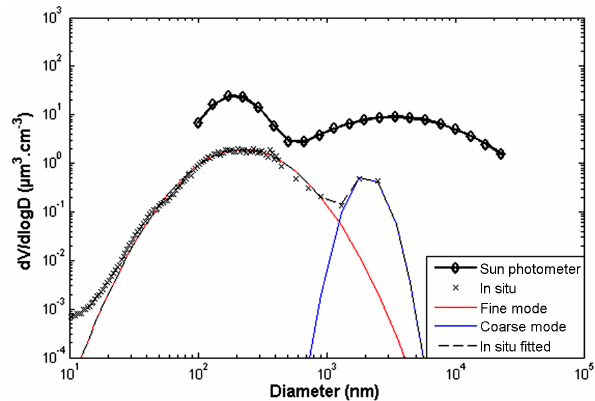
Figure 1. Volume particle size distribution from both in situ (cross) and sun photometer (bold line) measurements for 7 February 2011 at 11:03. In situ measurements (SMPS and OPC) are fit according to two modes, one fine mode (red line) and one coarse mode (blue line). The dashed black line is the sum of the two in situ